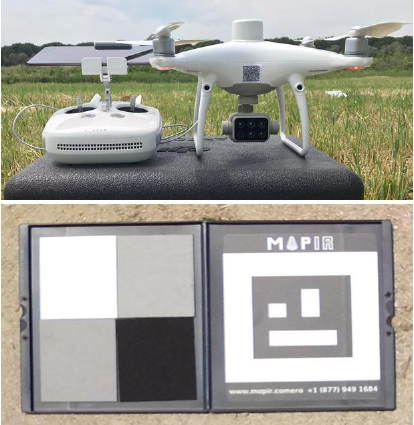
Figure 2. DJI Phantom IV Multispectral UAV and MAPIR Camera Reflectance Calibration Ground Target Package (V2)